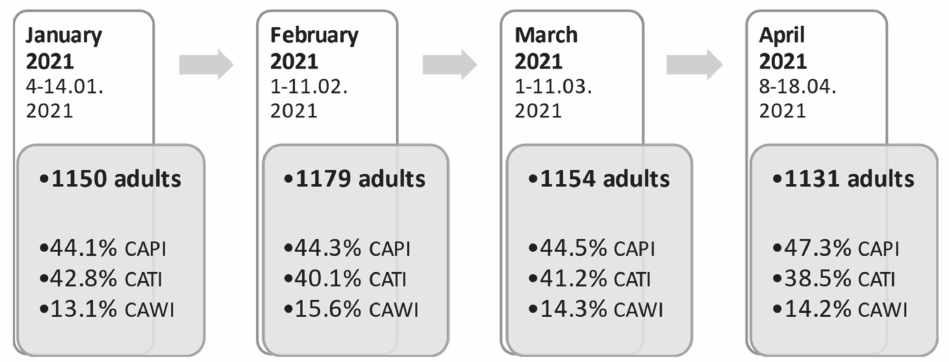
Figure 1. Study flow chart, January–April